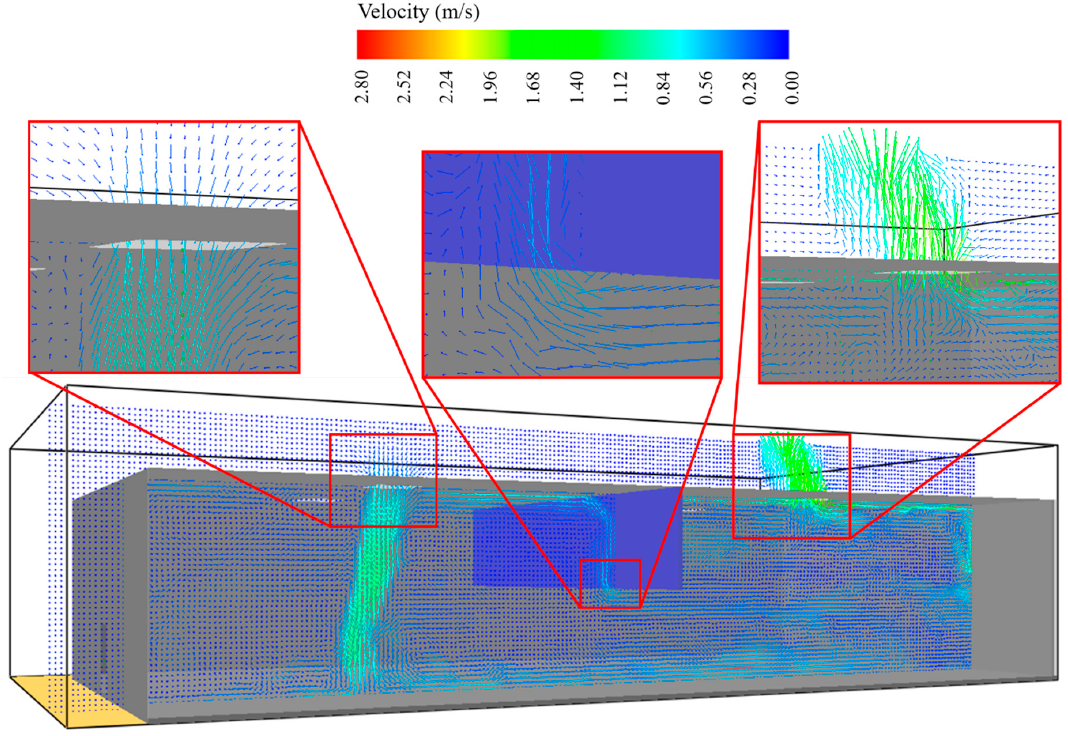
Figure 12. Velocity vector field in a plane that crosses two exhaust vents (y = 3.75 m) at time t = 600 s (case 9).